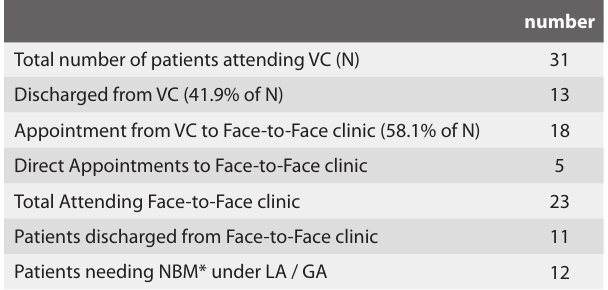
Table 2. Impact of video clinic in managing nasal bone trauma patients and an analysis of Face-to-Face clinic appointments *NBM (Nasal Bone Manipulation).